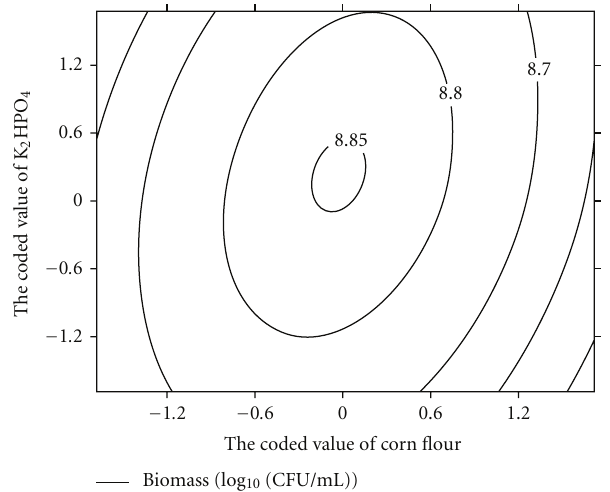
Figure 4: Contour plot for DNS 32 strain production as a function of X 1 (corn flour concentration) and X 3 (K 2 HPO 4 flour concentra- tion) when the coded value of X 2 (soybean concentration) was fixed at 0.